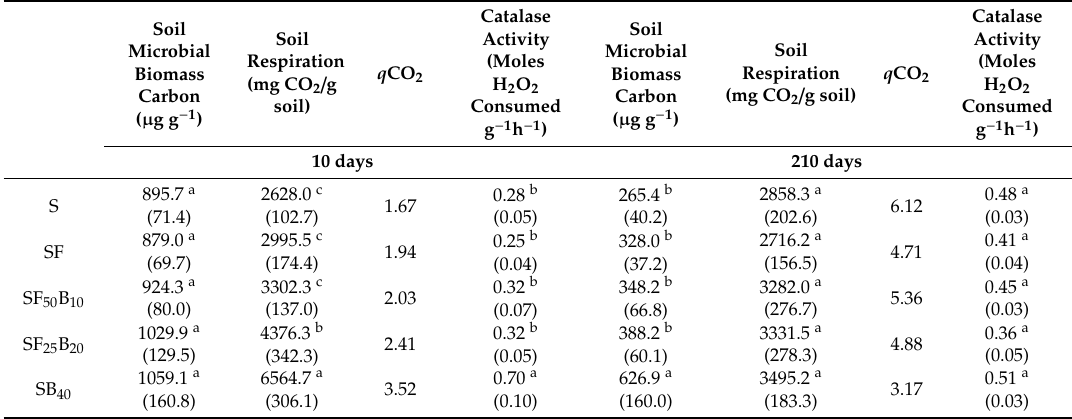
Table 1. Biochemical properties of soil amended with biosolids and inorganic fertilizer at 10 and 210 days after